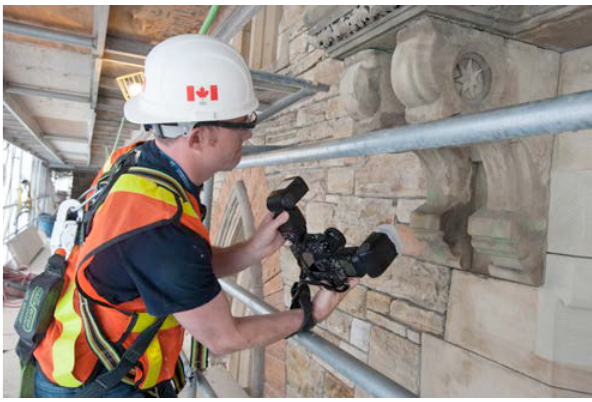
Figure 2. Data capture with a Nikon D3X DSLR